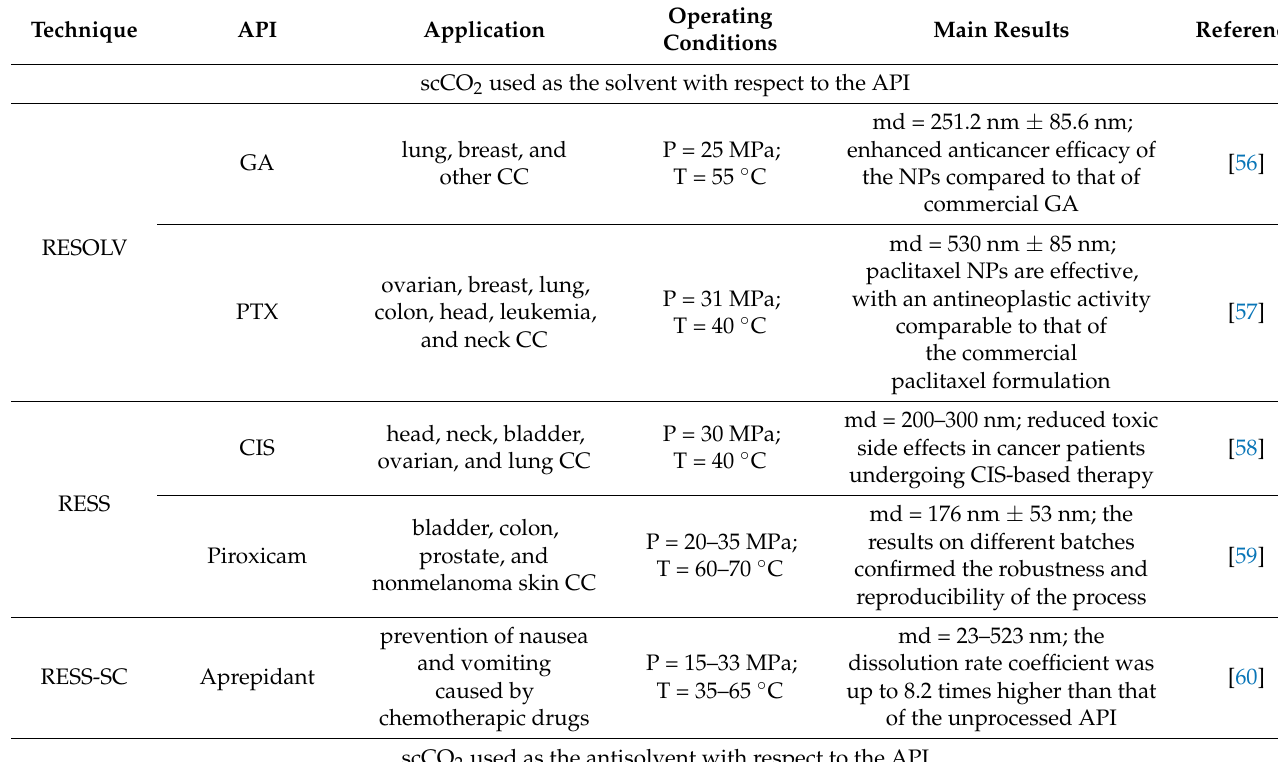
Table 2. Carrier-free nanoparticles. 5-FU = 5-Fluorouracil; API = active principle ingredient; CC = cancer cells; CIS = cisplatin; CPC = capecitabine; CPT = Camptothecin; DCM = dichloromethane; DMSO = dimethylsulfoxide; EtOH = ethanol; GA = gambogic acid; GAS = gas antisolvent; md = mean diameter; HCPT = 10-hydroxycamptothecin; NPs = nanoparticles; P = pressure; PTX = paclitaxel; RESOLV = rapid expansion from supercritical solution into liquid solvents; RESS = rapid expan- sion from supercritical solution; RESS-SC = rapid expansion from supercritical solution with solid cosolvent; SAS = supercritical antisolvent; T =